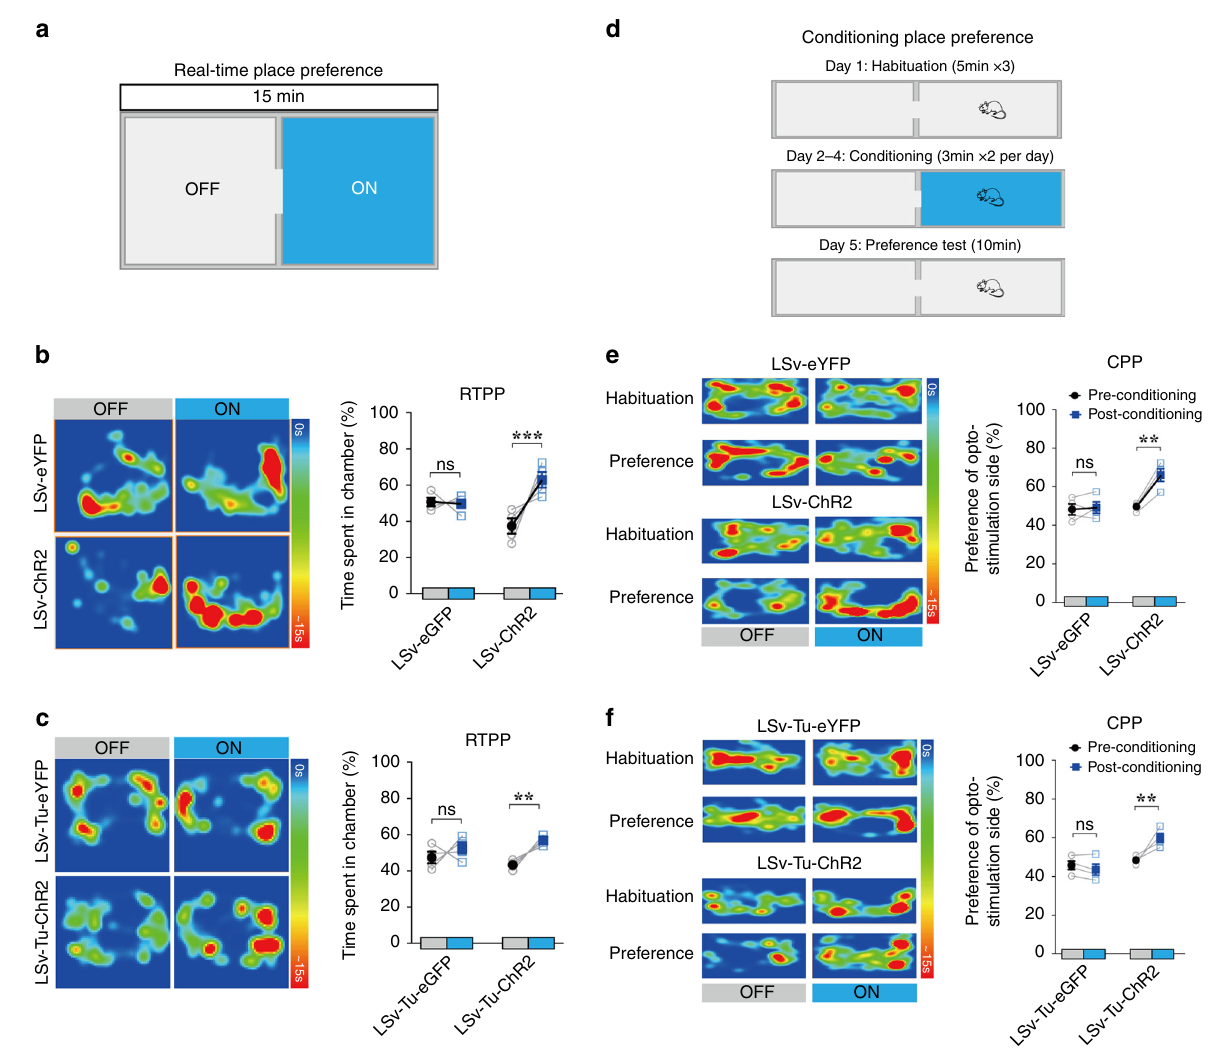
Fig. 3 Positive valence of LSv-associated grooming behaviour. a – c Schematics and results of real-time place preference (RTPP) test based on a dual chamber setup showing increased time spent by an animal in the chamber that was associated with optogenetic stimulation of the LSv ( b , Interaction; F (1, 6) = 8.908, P = 0.0245; Virus main effect; F (1, 6) = 1.589e − 031 , P > 0.9999; optostimulation main effect; F (1, 6) = 34.35, P = 0.0011; *** P = 0.0005) or LSv → Tu pathway ( c , Interaction; F (1, 6) = 4.789, P = 0.0712; virus main effect; F (1, 6) = 2.139e − 030 , P > 0.9999; optostimulation main effect; F (1, 6)